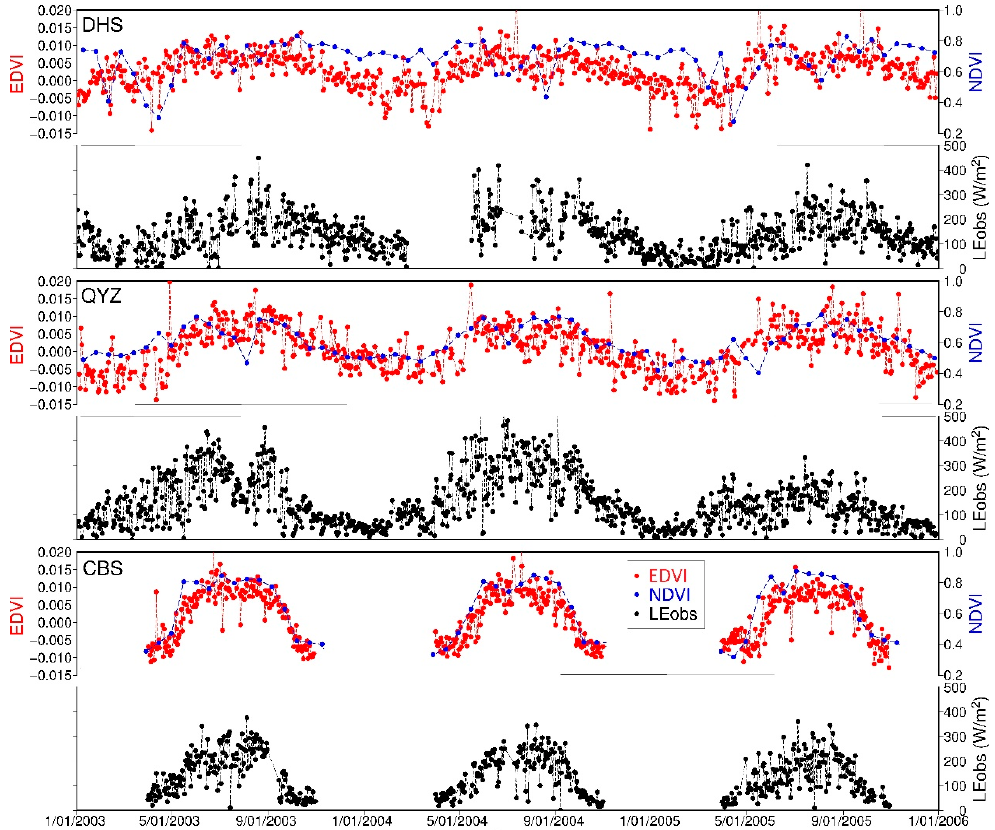
Figure 2. Time series of EDVI, in-situ measured LE (averaged over 2 h around the satellite overpass), and 16-day NDVI from 2003 to 2005 at three forest sites of ChinaFLUX. QYZ forest site had a serious imbalance of energy in 2005.